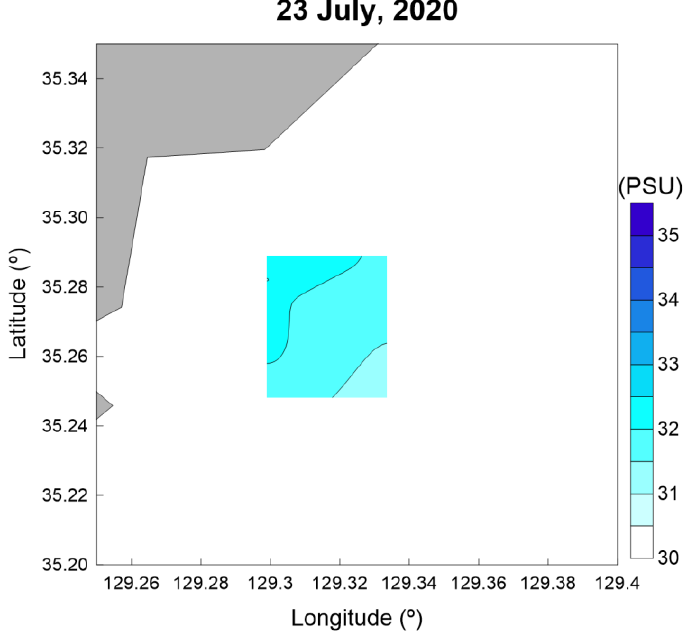
Figure 24. Distribution of salinity in the major swimming layers in the Gijang coastal waters sea (23 July 2020).